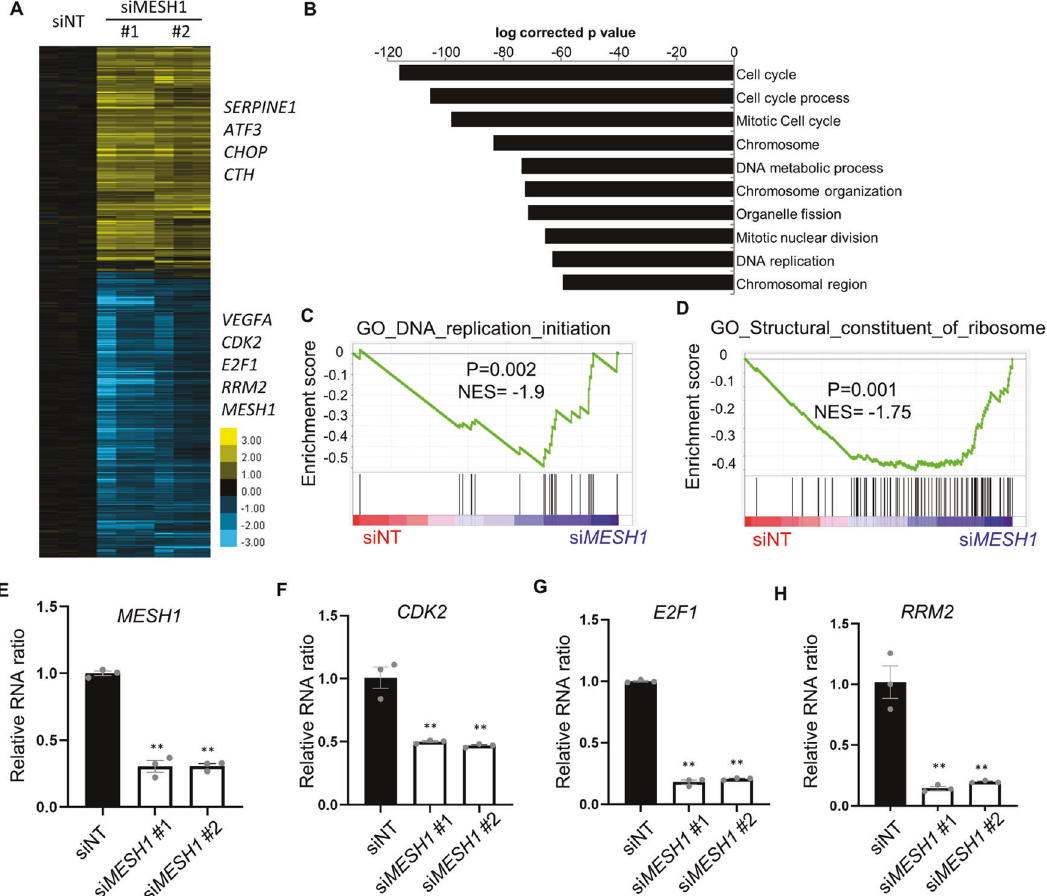
Fig. 1 MESH1 knockdown suppresses a transcriptional response of cell cycle progression. A Heatmap of the transcriptional difference between control or two independent MESH1 siRNA knockdown in RCC4 cells. MESH1 was silenced by siMESH1#1 or siMESH1#2 and pro fi led by RNA-seq. Color scale indicates log2-fold-change. B Top ten repressed Gene Ontology processes of the transcriptome of MESH1 -silenced RCC4 cells. C , D GSEA analysis showed the enrichment of DNA replication geneset ( C ) and constituent of ribosome ( D ) in the MESH1 knockdown cells. E – H mRNA abundance of MESH1 ( E ), CDK2 ( F ), E2F1 ( G ), and RRM2 ( H ) as validated by rt-qPCR. mRNA abundance was determined by rt-qPCR, normalized by β -actin, and presented in relative ratio to siNT (non-targeting) treatment. n = 3 biological